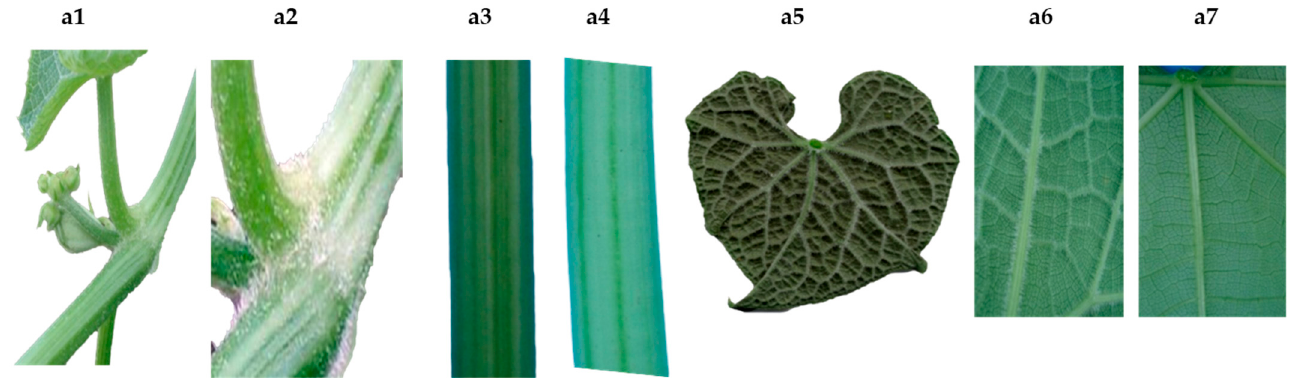
Figure 2. Quantitative and qualitative morphological characteristics of biological variants that allow varietal distinction of Sechium edule . Pubescence ( a1 , a2 ); color and striation of the guide ( a3 , a4 ); shape, pubescence, and leaf venation ( a5–a7